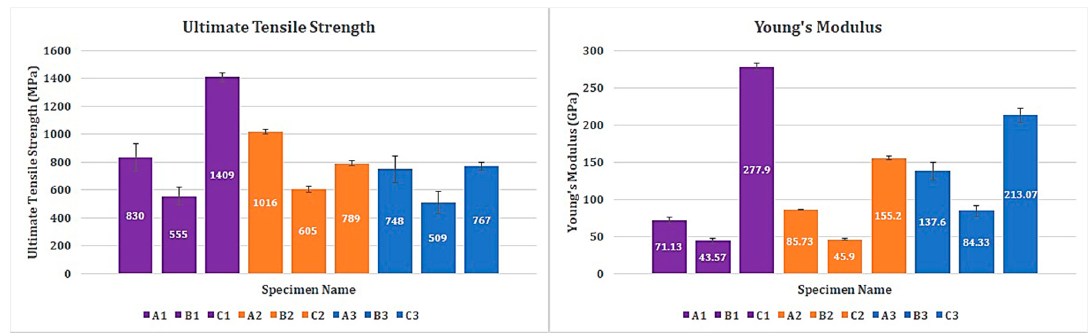
Figure 1. Ultimate tensile strength and Young’s modulus of all specimens tested.